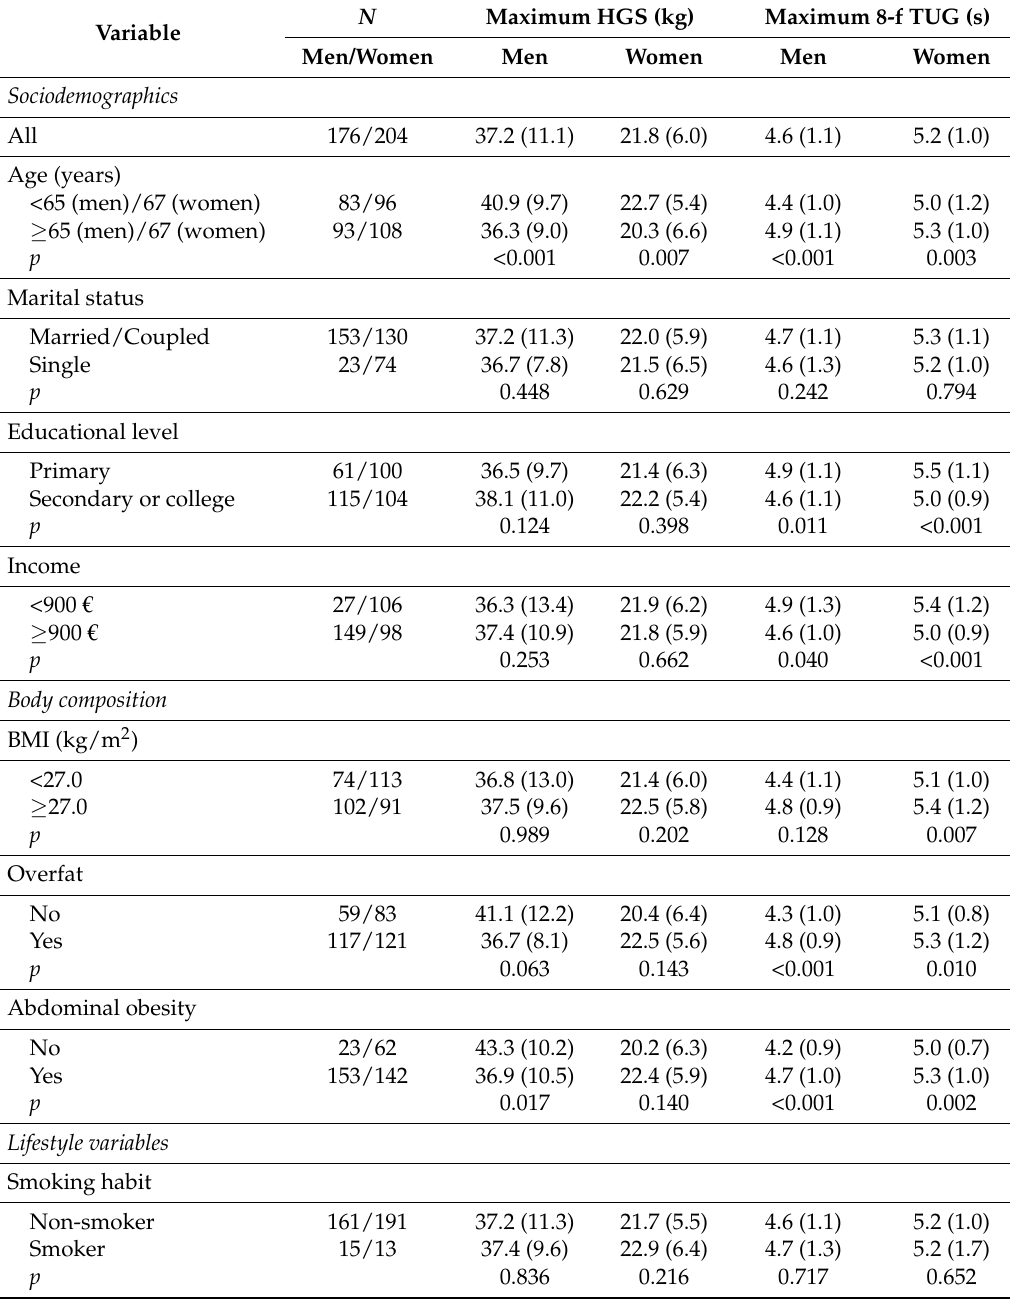
Table 1. Maximum handgrip strength (HGS) and maximum eight-foot time up-and-go (8-f TUG) score among older adults according to sociodemographic, body composition and lifestyle variables stratified by